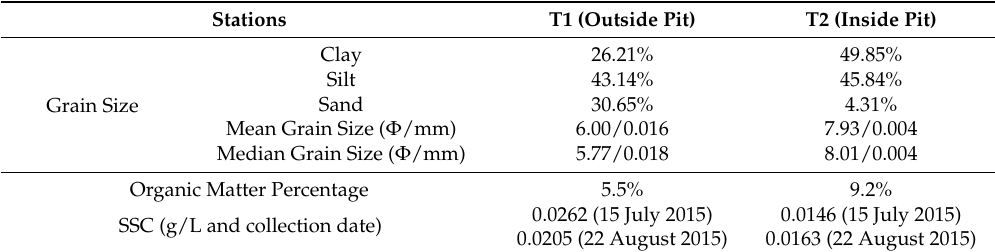
Table 2. Grain Size, Organic Matter and Total Suspended Sediment at Stations T1 and